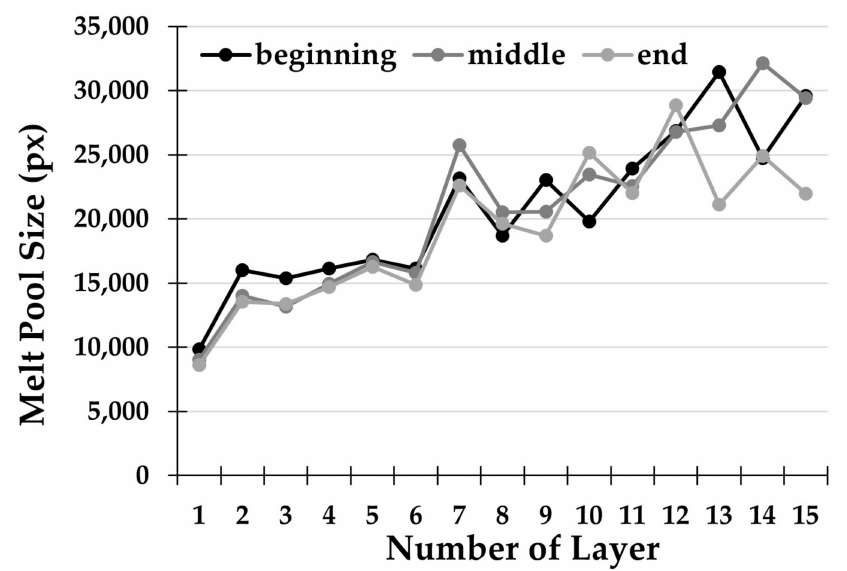
Figure 5. Melt pool size for each deposited layer with strategy